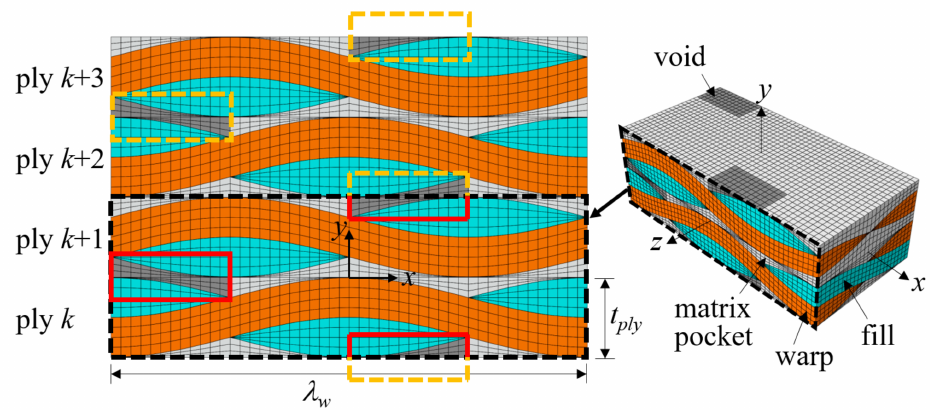
Figure 23. Definition of void type from regional pattern of matrix pocket for two-ply shifted plain weave unit cell ( ∆ x = λ w /4